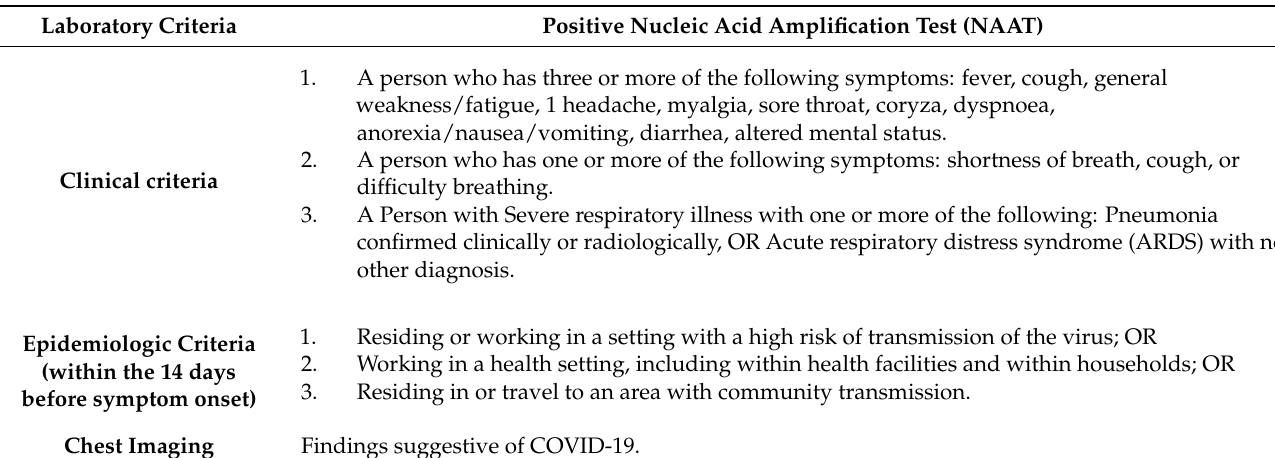
Table A2. Diagnosis Criteria Used in Chart Review and Data